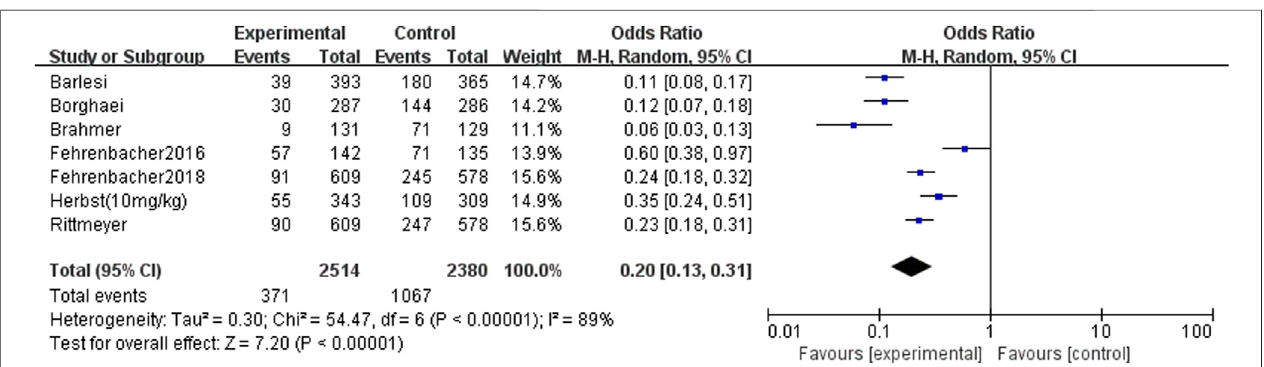
FIGURE 6 | Comparison of treatment-related grade 3 or higher adverse events between